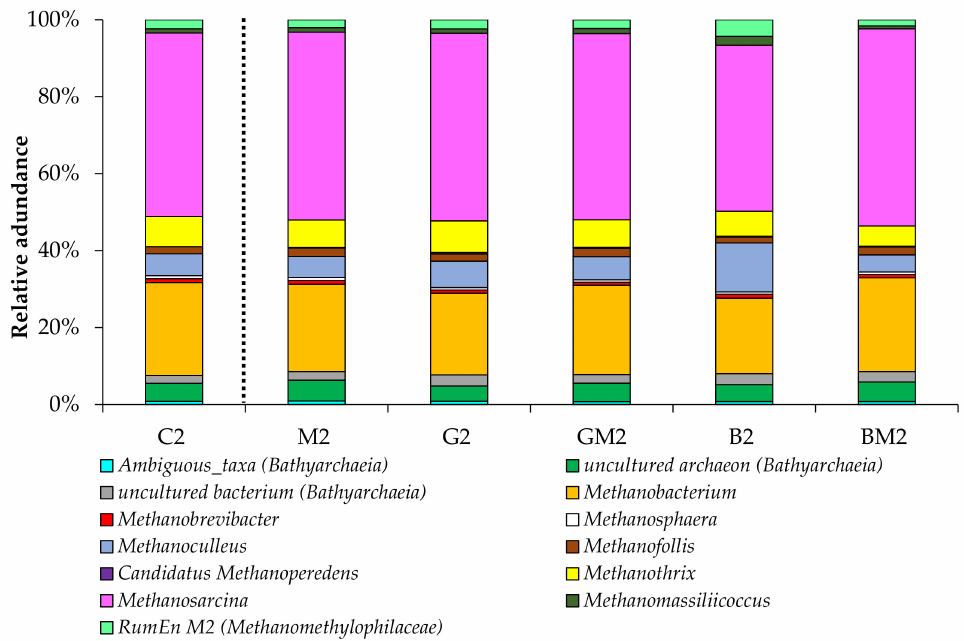
Figure 7. Taxonomic composition of archaeal communities in the anaerobic reactors (sampled on day 6; genus